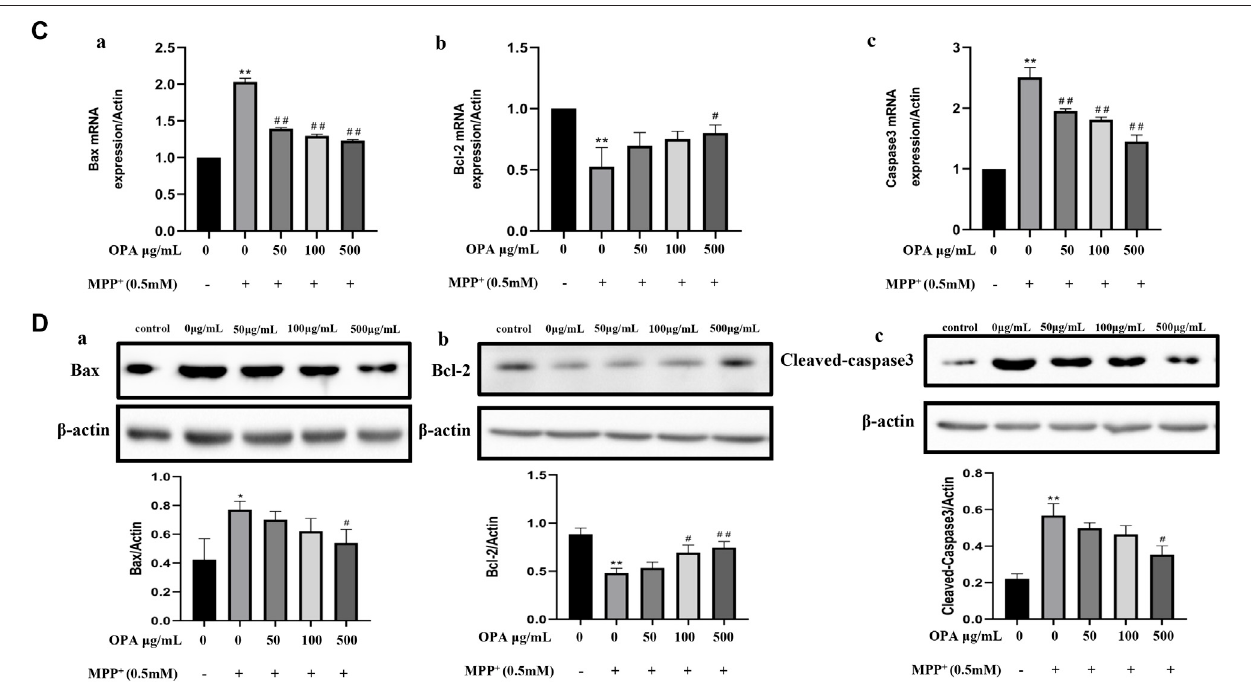
FIGURE2| EffectsofOPAontheMPP + -inducedapoptosisofSH-SY5Ycells.SH-SY5YcellsweretreatedwithandwithoutvariousconcentrationsofOPAfor24 h before exposed to MPP+ (0.5 mM) for an additional 24 h. The apoptotic cells were tested by (A) Hoechst 33,342 staining and (B) fl ow cytometry analyses, in which (a) wastherepresentative image, and (b) indicated thepercentageofapoptotic cells. White arrows representedthe location ofapoptotic cells. (C) qPCR wasconductedto analyzethemRNAlevelsof(a)Bax,(b)Bcl-2and(c)Caspase3. (D) proteinlevelsof(a)Bax,(b)Bcl-2and(c)Cleaved-Caspase3weredetectedbywesternblot.The densityofbandswasnormalizedwiththatof β -actin.Datawerepresentedasmean±SDforthreeindependentexperiments.* p < 0.05,** p < 0.01comparedwithcontrol cells untreated with OPA and MPP + ; # p < 0.05, ## p < 0.01 compared with MPP + -treated